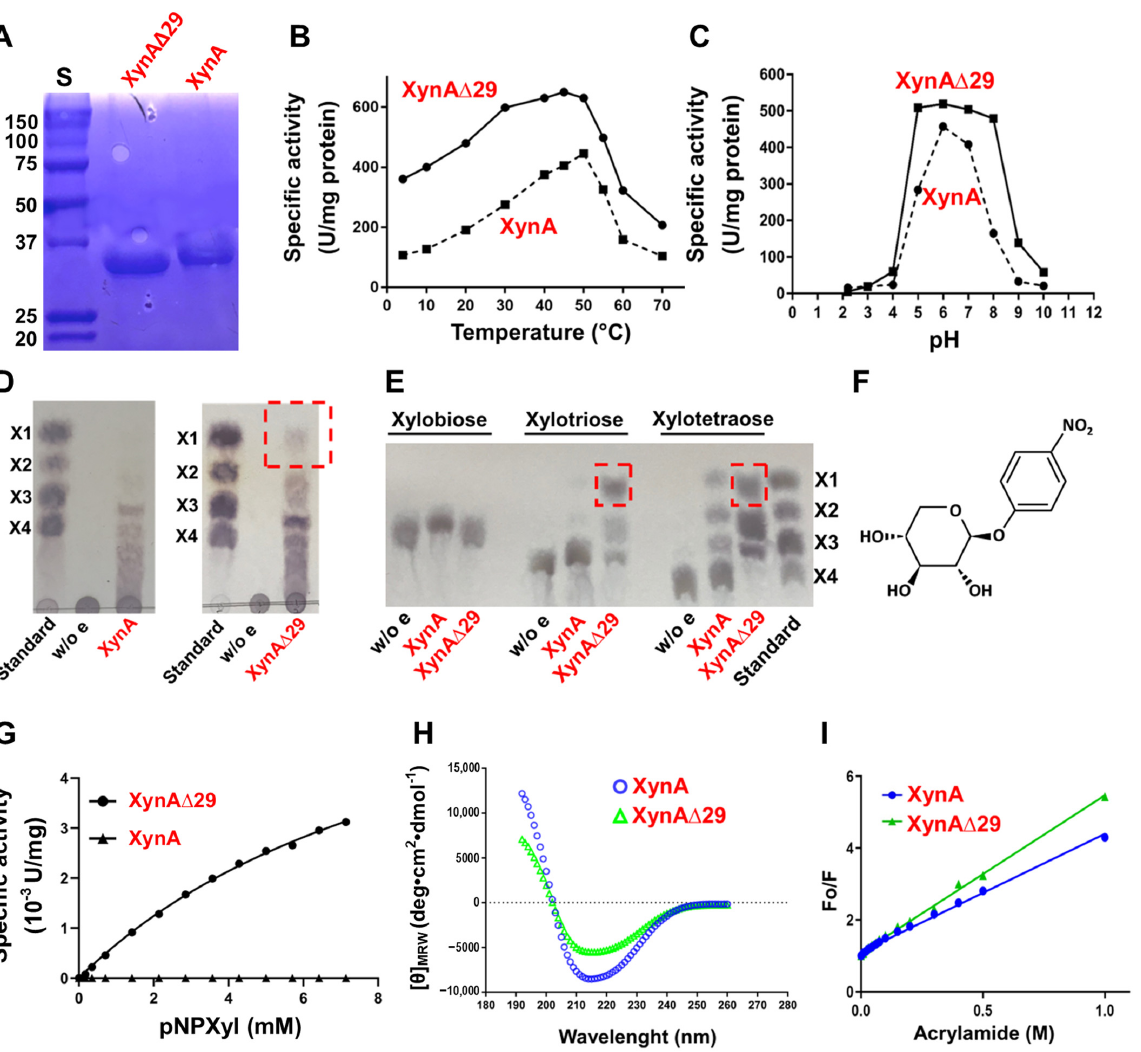
Figure 2. ( A ) SDS-PAGE of purified enzymes. S: Molecular weight standard in kDa. ( B ) Xylanolytic activity of XynA and XynA ∆ 29 at different temperatures. ( C ) Xylanolytic activity of XynA and XynA ∆ 29 at different pH. ( D ) TLC of the products released from xylan. ( E ) TLC of the products released from XOS. Xylose released by XynA ∆ 29 is highlighted in red boxes. Controls without enzymes (w/o e), and standards xylose (X1), xylobiose (X2), xylotriose (X3), and xylotetraose (X4) were included. ( F ) Structure of pNPXyl. ( G ) Michaelis–Menten plot of the hydrolysis of pNPXyl by XynA and XynA ∆ N29. ( H ) Far-UV circular dichroism spectra of XynA and XynA ∆ 29. The mean residue ellipticity ([ θ ] MRW ) was plotted against wavelength. ( I ) Stern-Volmer plot for tryptophan fluorescence quenching by acrylamide of XynA and XynA ∆ 29. In ( B , C , G , I ) values are the mean of three experiments, bars representing the standard error of the mean lie within the size of the